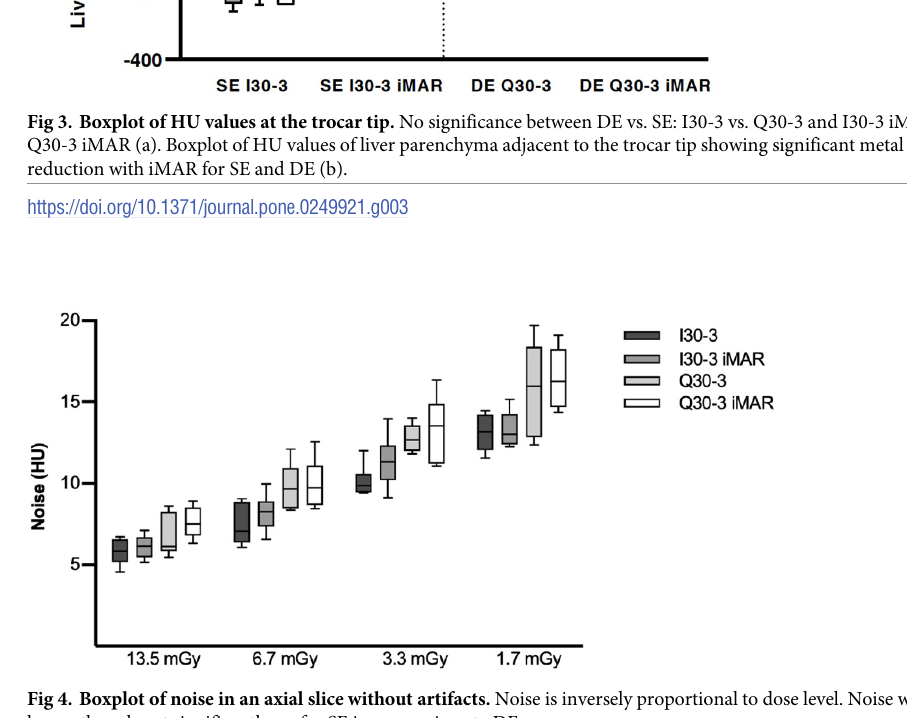
PLOS ONE | https://doi.org/10.1371/journal.pone.0249921 April 26,